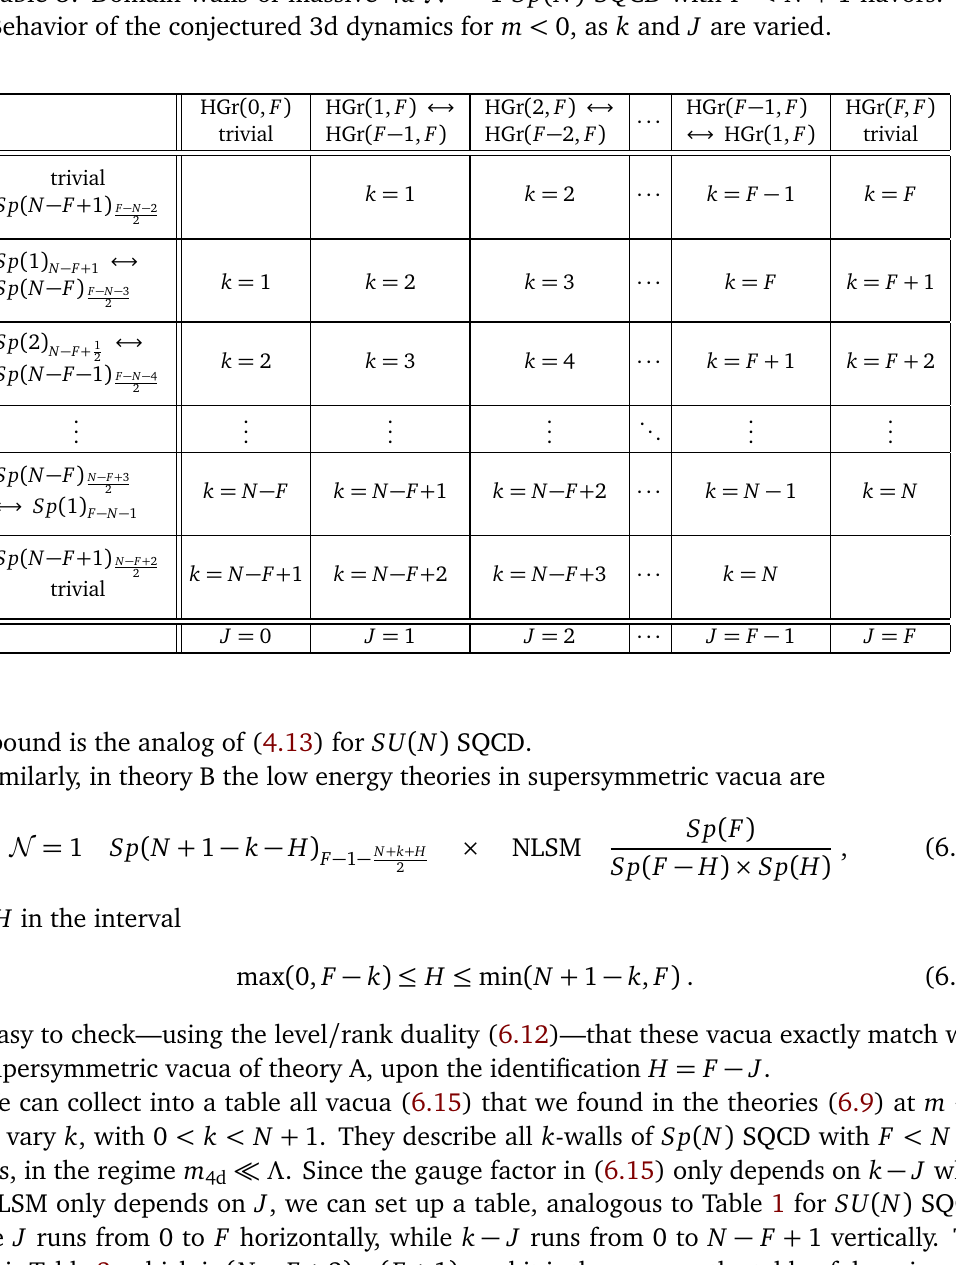
= 1 Sp ( N ) SQCD with F < N + 1 N